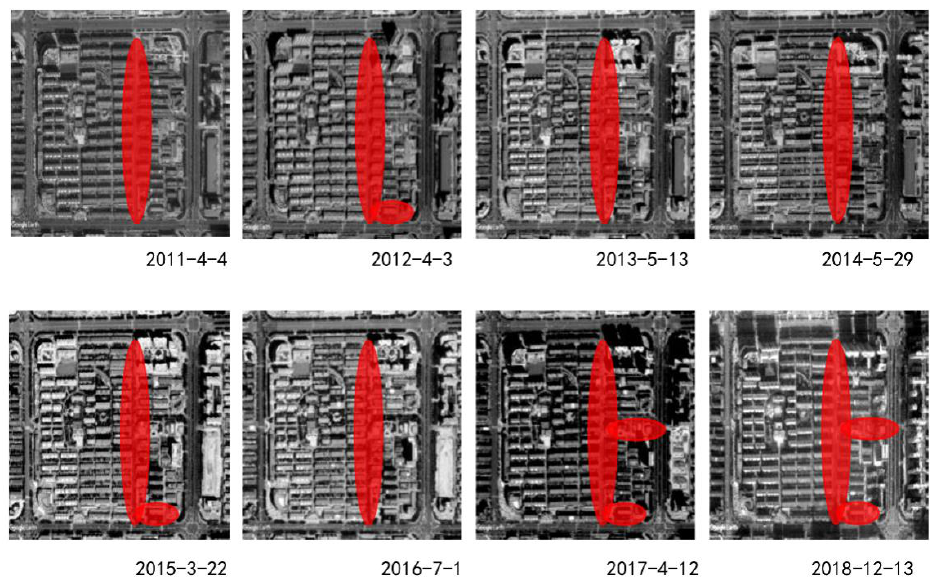
Figure 9. Evolution process ofZhaoTuan fairs in 2011–2018.(Source: Own drawing).